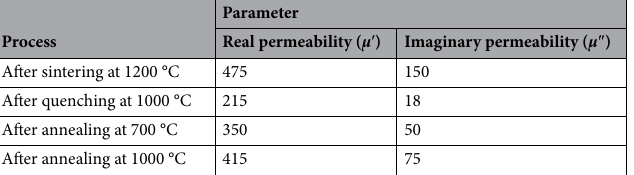
Table 1. The real ( µ ′ ) and imaginary ( µ ″ ) permeability after sintering, quenching and after annealing at 3